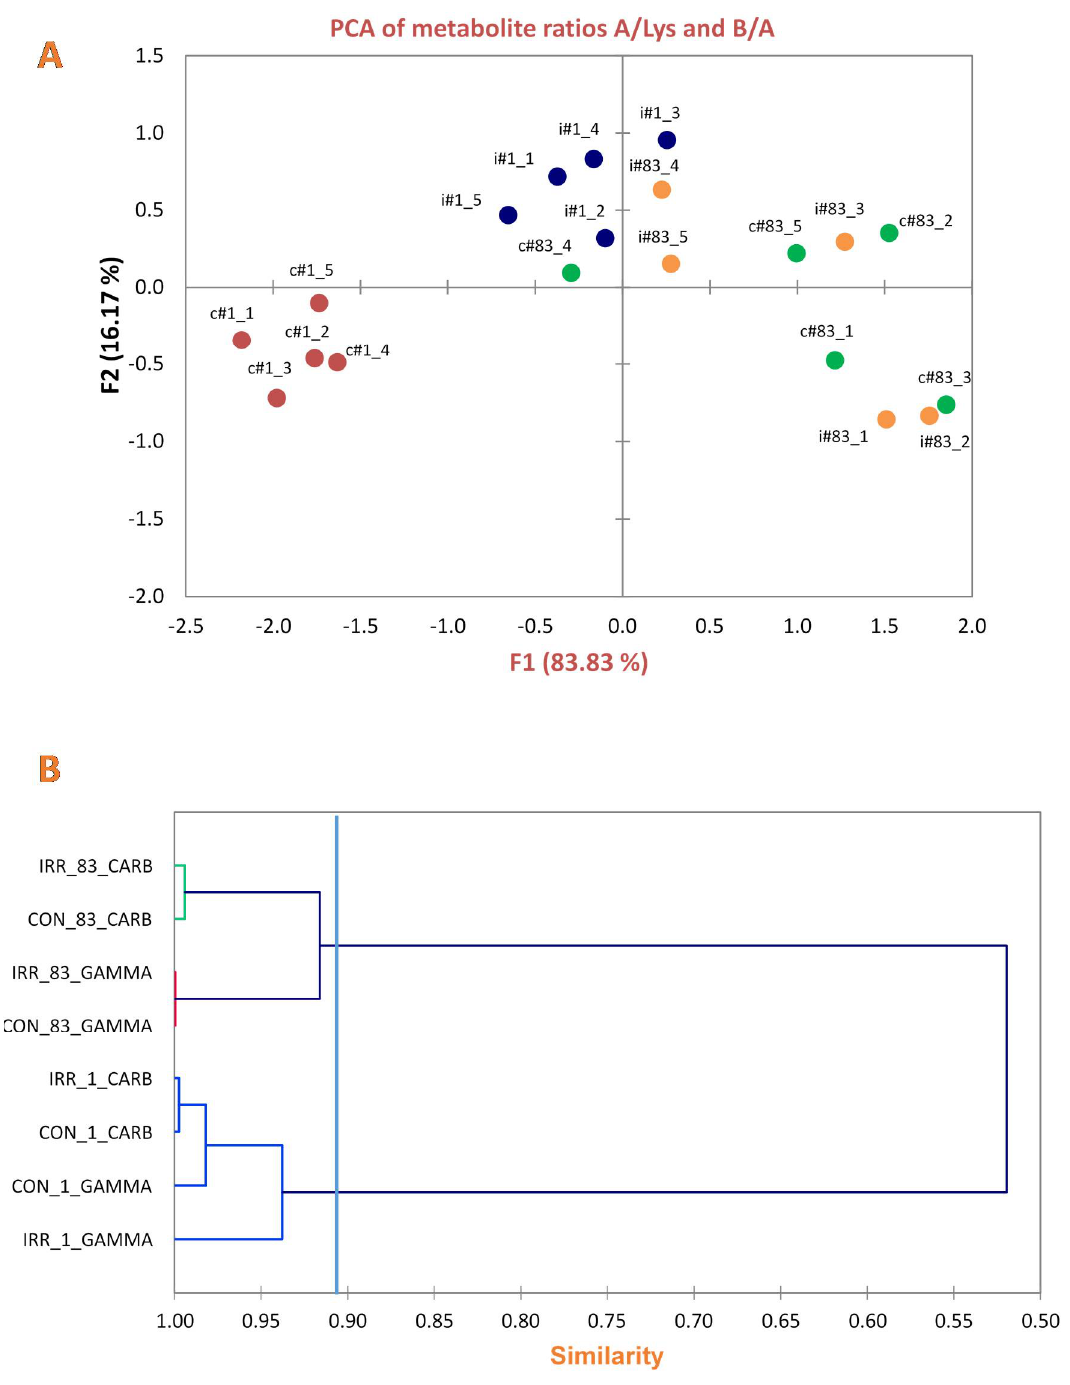
Figure 4. Statistical analysis confirms a different metabolic behaviour of line #1 and #83 cells after irradiation ( A ) F1 vs. F2 plot from Principal Component Analysis of observations of ML cross peak A and cross peak ratio B/A from 2D NMR spectra, for line #1 and #83. Peak A at (0.89–1.28) ppm arises from the correlation of CH3-terminal methyl group of FA chains with the bulk of FA (excluding omega-3 FAs). Peak B at (2.02–1.28) ppm represents both mono and polyunsaturated FA with a different contribution from n-9 and n-3 chains. F1 and F2 are the first and the second components in the PCA space, that account for 83.83% and 16.17%, respectively representing 100% of the total variances existing along the obtained data. Each point in the plot corresponds to the mean value of at least three experiments at different times after irradiation. ( B ) Dendrogram resulting from Unsupervised Cluster Analysis of GSH, gln, glu and GABA mean signal intensities from experiments at different times after irradiation.